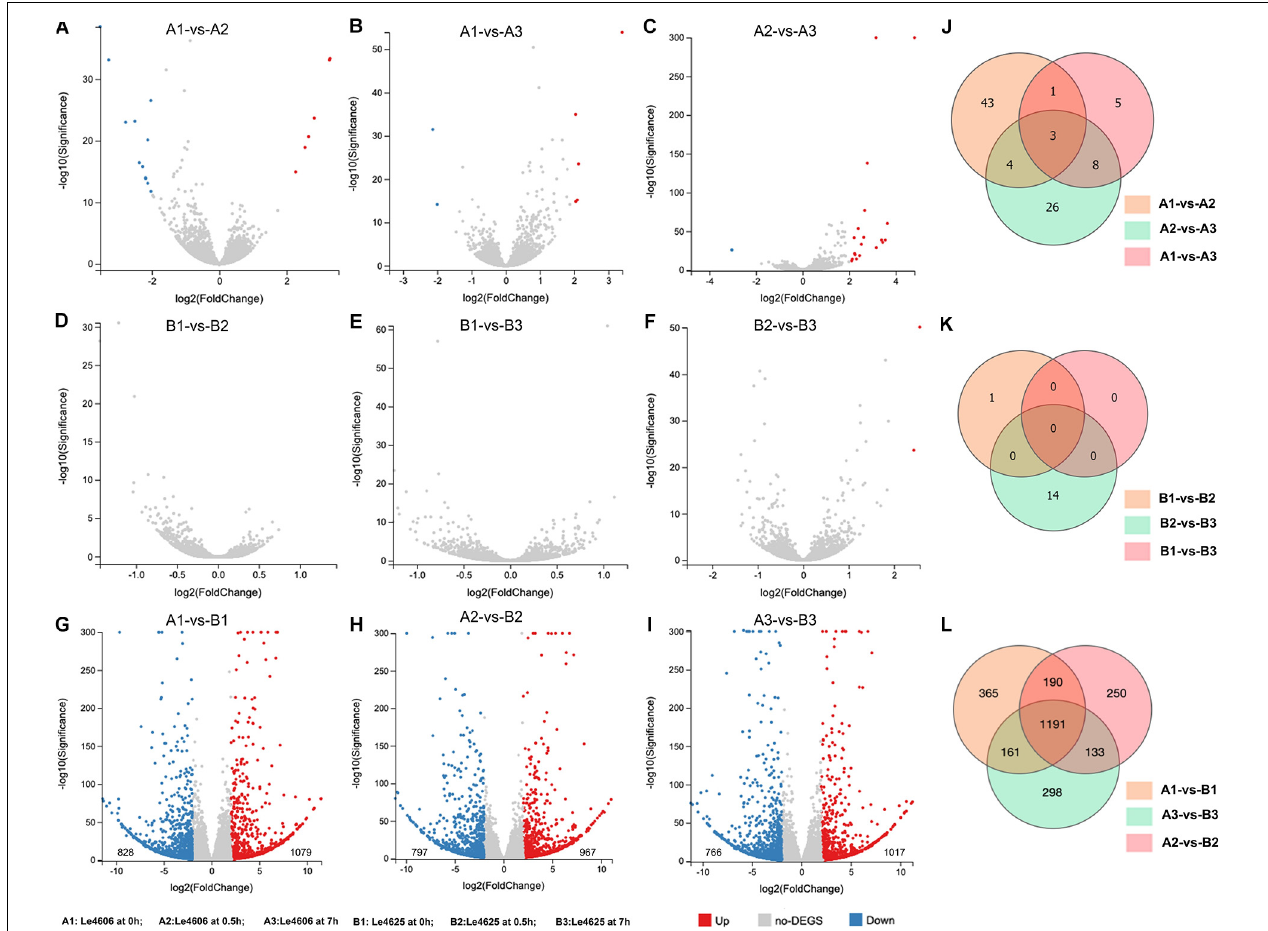
FIGURE 3 | Statistics for differentially expressed genes between Le4606 and Le4625. (A–C) Volcano plots of the pairwise comparison of DEGs between three treatments (Cd exposure for 0, 0.5, and 7 h) in the Le4606 genotype. (D–F) Volcano plots of the pairwise comparisons of DEGs between three treatments (Cd exposure for 0, 0.5, and 7 h) in the Le4625 genotype. (G–I) Volcano plots of DEGs between Le4606 and Le4625 after Cd exposure for 0, 0.5, and 7 h. (J–L) Venn analysis of intra-genotype and inter-genotype DEGs for Le4606 and